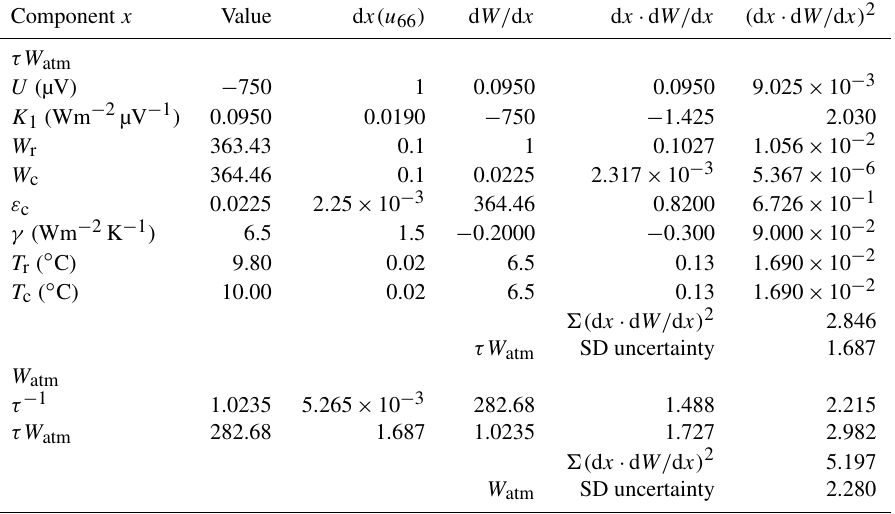
Table 1. The standard uncertainty calculation for W atm = 289 . 33Wm − 2 by calculation by Eq. (18). The first 11 component rows provide the calculation of the standard uncertainty for τW atm , while the remaining rows provide the calculation of the standard uncertainty for W atm . Apart from irradiance components ( W x ) and dimensionless quantities ε c and τ , the units of the components are provided in the first column. Component x Value